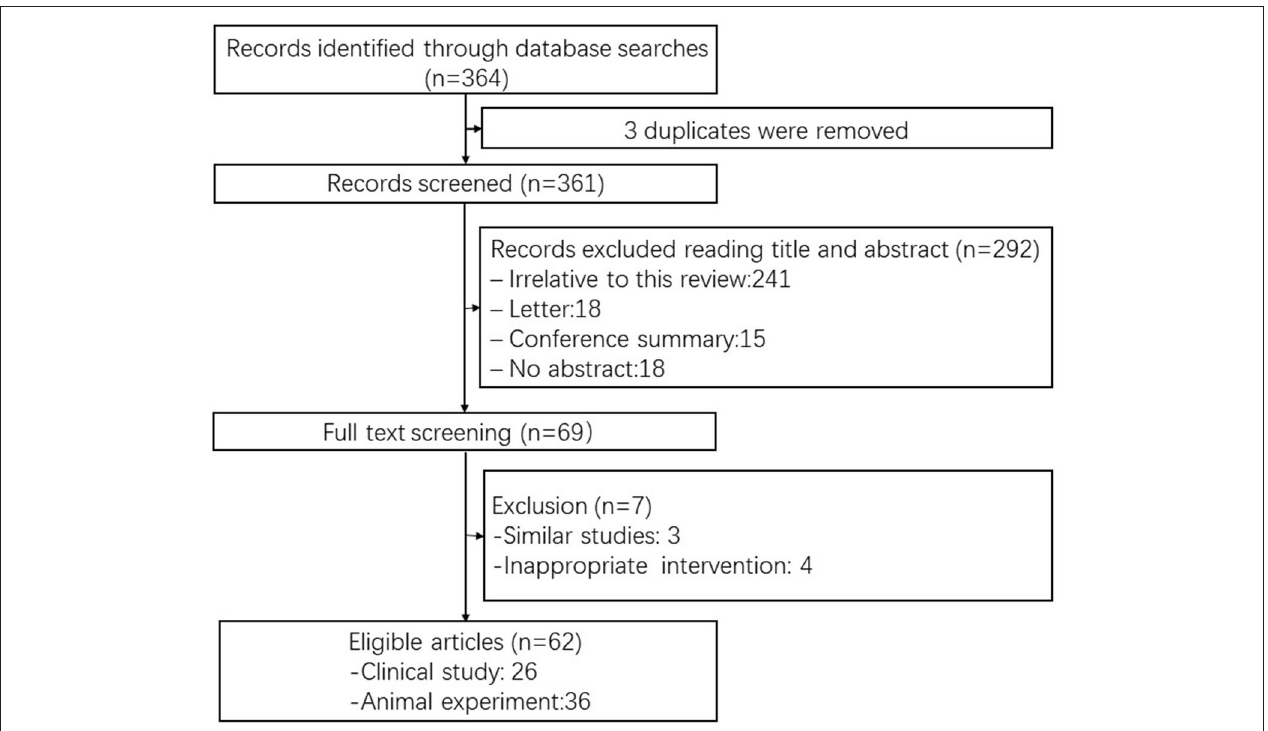
FIGURE 1 | Flow diagram of the study selection